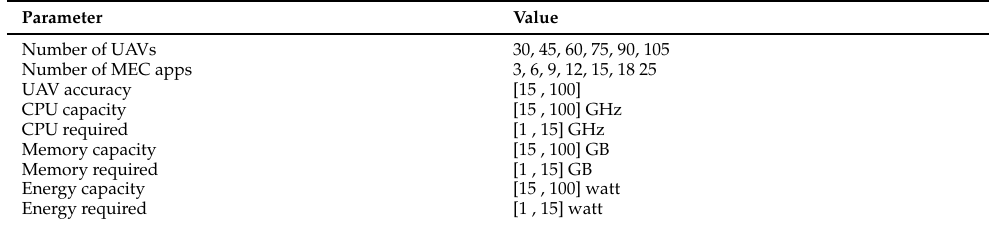
Table 3. Simulation Parameters.